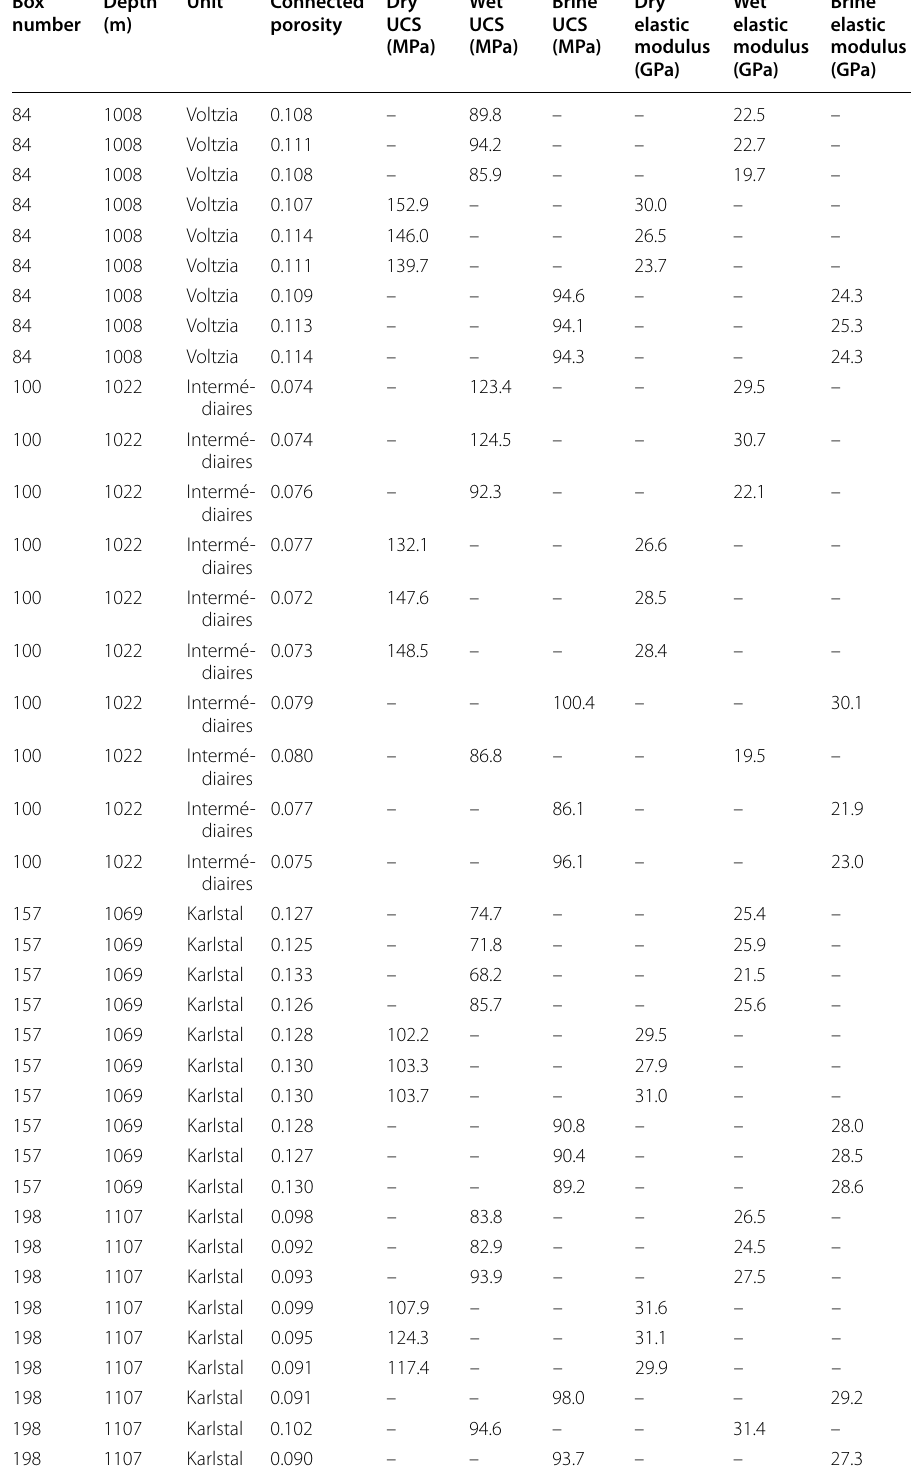
Table 4 Summary of the dry, water‑saturated (wet), and brine‑saturated (brine) uniaxial compressive strength experiments performed on the six sandstones sampled from exploration well EPS‑1 at the Soultz‑sous‑Forêts geothermal site